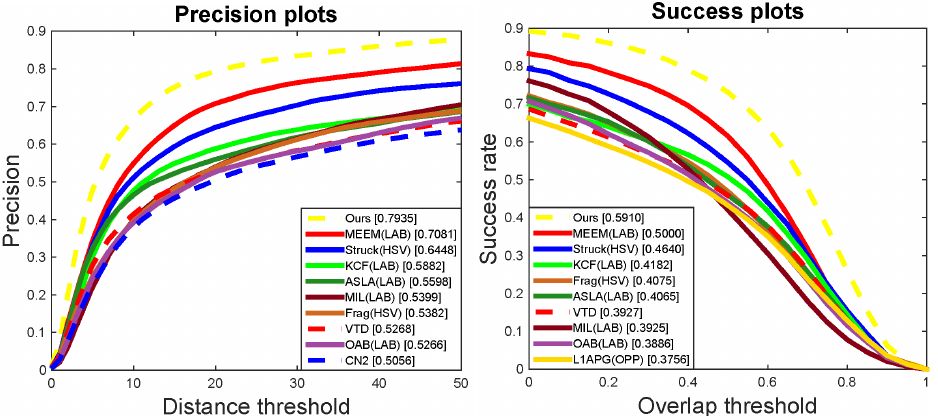
Figure 11. Precision and success plot on the Temple-color-128 dataset. The AUV and precision score of each tracker is shown in the legend. For clarity, we only show the top 10 trackers for